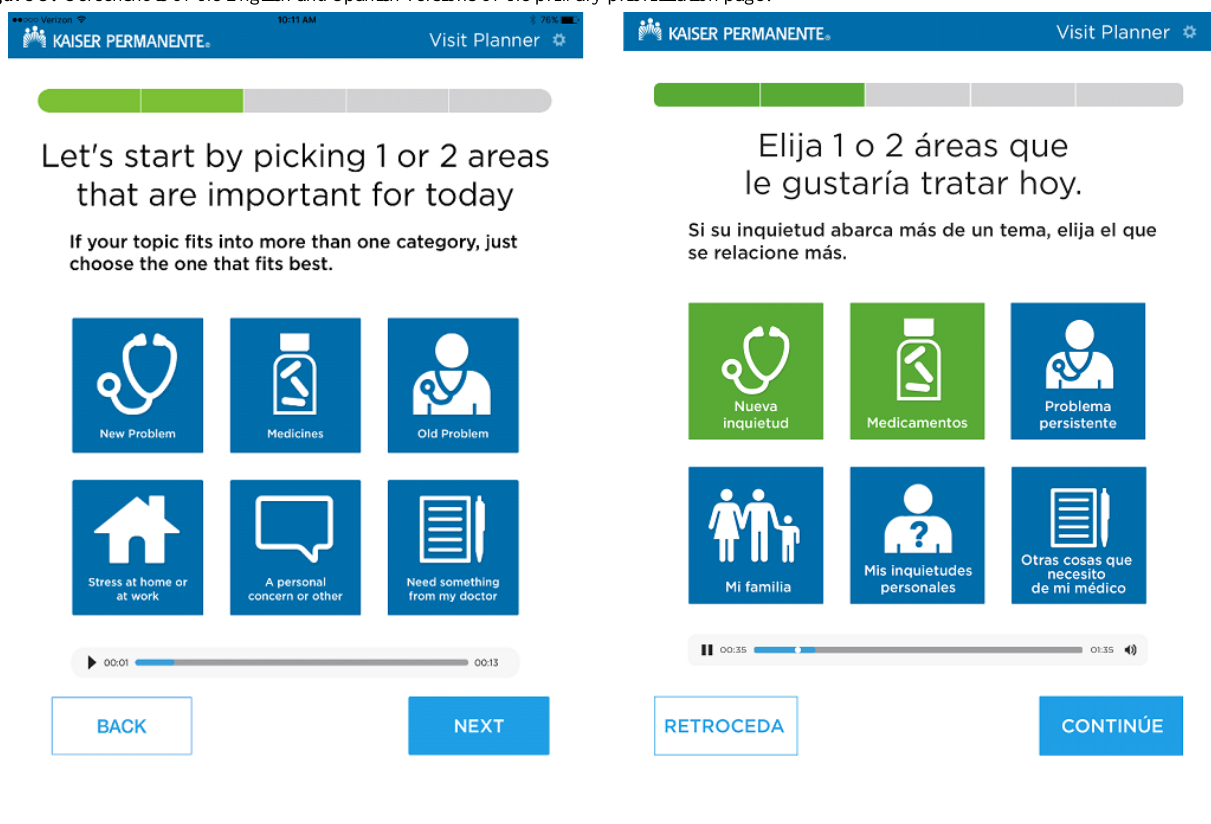
Figure 3. Screenshots of the English and Spanish versions of the primary prioritization page.